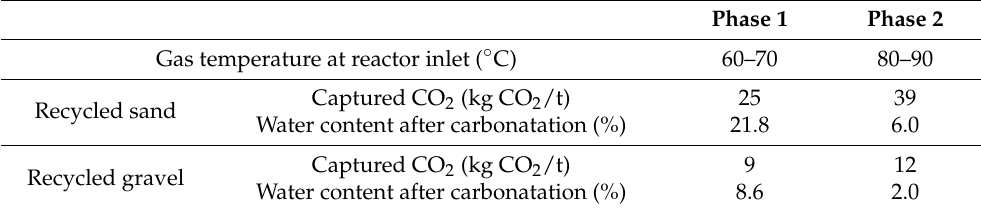
Table 2. Quantities of CO 2 captured by recycled aggregates in the fluidized bed